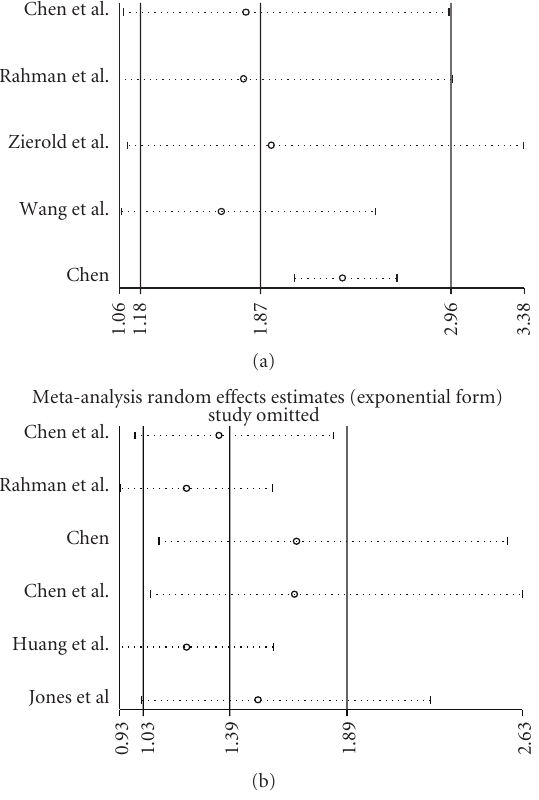
Figure 2: (a) Influence analysis for arsenic concentration as expo- sure assessment, (b) influence analysis for arsenic concentration and duration as exposure